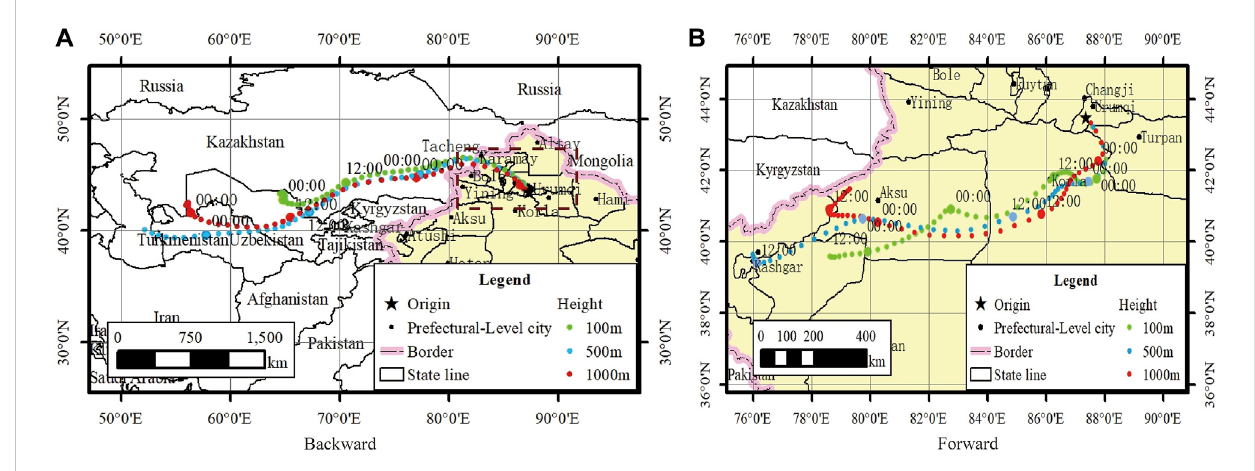
FIGURE 8 HYSPLIT backward (A) and forward (B) trajectories of Urumqi air at 19:00 on April 27th (48